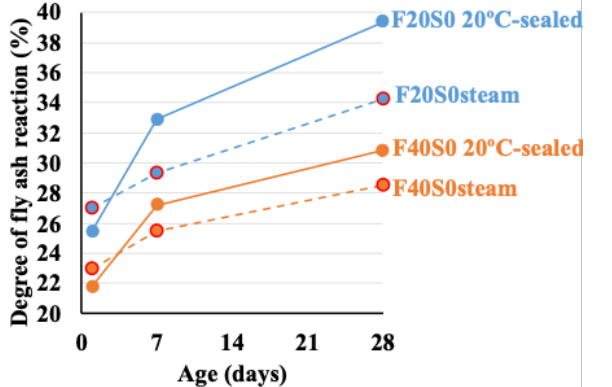
Figure 7. Relationship between k-value and degree of fly ash